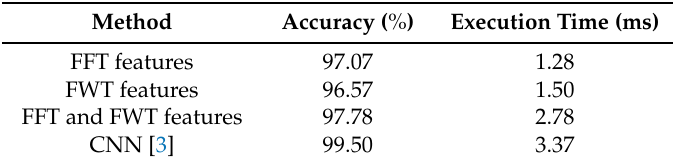
and accuracy (with one DT for the feature based approaches). The results are based on the work in